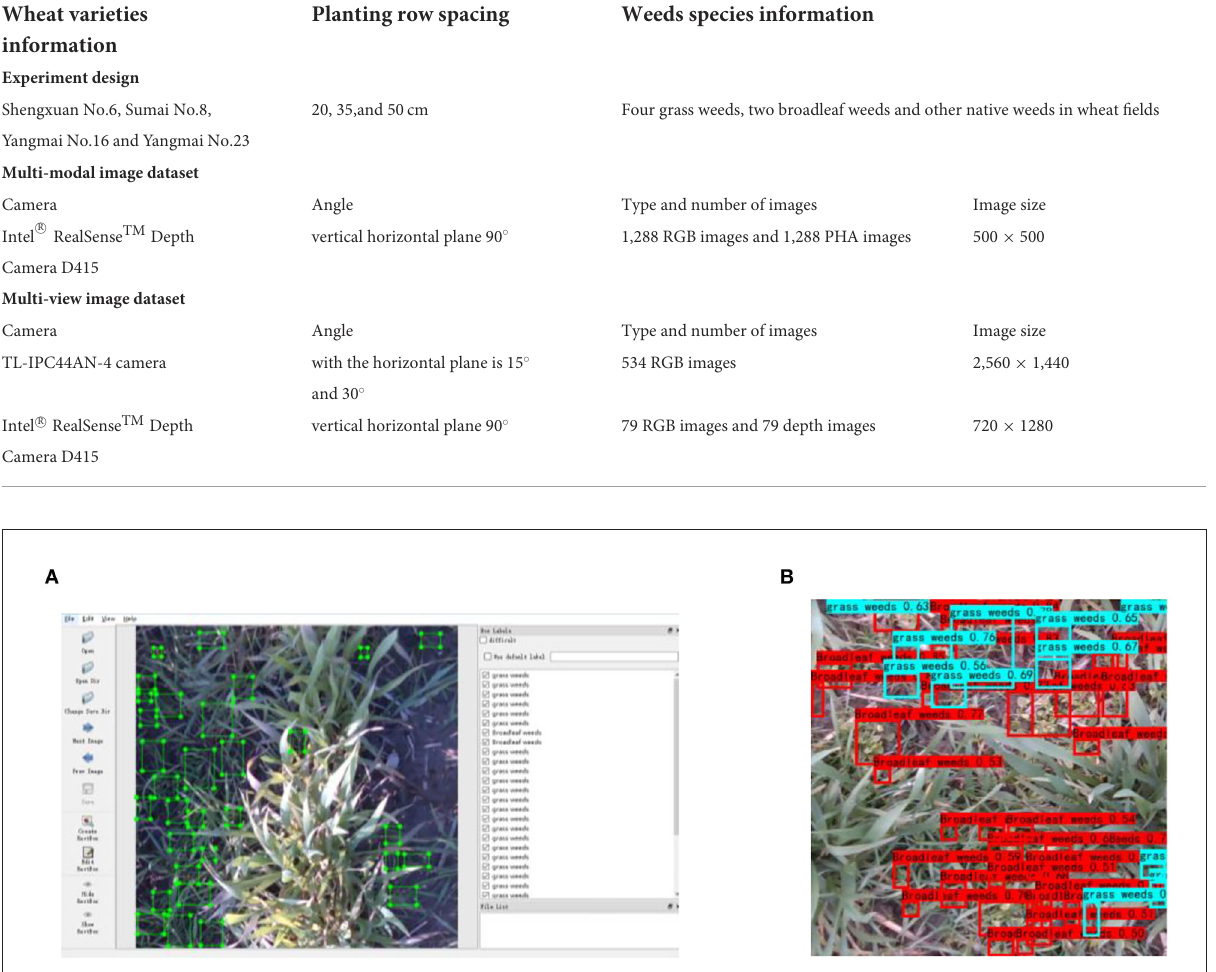
vertical view, 79 vertical depth images corresponding to vertical view RGB images, and 534 images from eight other